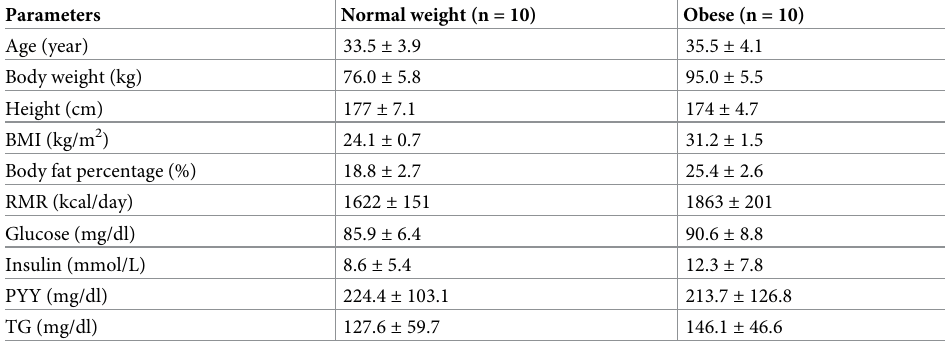
Table 3. Baseline measurements of subjects.